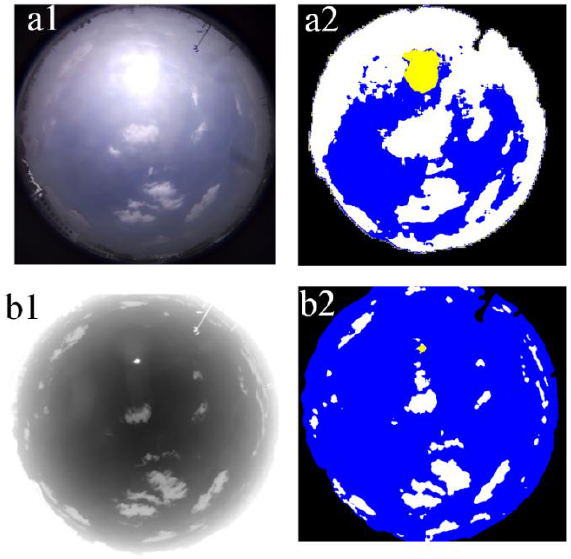
Figure 11. Comparison of the cloud detection results of infrared and visible images with hazy weather conditions. Figures 11( a1 ) and ( b1 ) show the visible and TIR cloud images, respectively. Figures 11( a2 ) and ( b2 ) are the results of the cloud identification of the two cloud images. Sometimes the scattering of sunlight by particles in the atmosphere causes the all- visible image to glow blue, even in the areas with clouds. In this case, the clouds in the visible image were incorrectly identified as blue sky, resulting in the cloud fraction of visible less than infrared. In addition, the dust protection cover in front of the lens can also lead to a difference in cloud recognition between the visible and infrared images. 4.3. Recognition Accuracy of Different Types of Clouds by Infrared Observation To analyze differences in cloud fraction of different types of clouds, the cloud fraction data from visible and infrared sky images with different types of clouds were compared in this study. A dataset containing 333 sets of sky images with different cloud types was established with the help of professional meteorological observers and based on the sky visible images (at the same time, the types of clouds in visible and infrared are the same). The dataset was collected at the Anhui Air Traffic Management Bureau in Hefei city for seven months (from June 1st to December 31st, 2019 LT). This period is long enough for ASC-200 to capture different types of cloud images. Due to the correlation between cloud type and cloud-based height (CBH), the classification accuracy was improved by using the CBH data, which was measured by the laser ceilometer VAISALA CL31. In the international cloud classification system published by the World Meteorolog- ical Organization (WMO) (1987), clouds are classified into ten types. Based on visual sim- ilarity, meteorological observers combined some clouds genera to reduce the chance of error in manual classification. Therefore, the cloud conditions are classified into six cate- gories: altocumulus (AC), cirrus (CI), cumulus (CU), stratocumulus (SC), stratus (ST), and cloud-free (CF). Due to the lack of available data, as well as the difficulty in detecting very thin clouds, some types of cirrostratus were merged, such as the genera CI and cirrostra- tus. In Table 1, the characteristics of several types of clouds are briefly described. Mean- while, the CBH data of different types of clouds in the dataset are presented in the table . Table 1. Characteristics of various clouds. Clouds Types